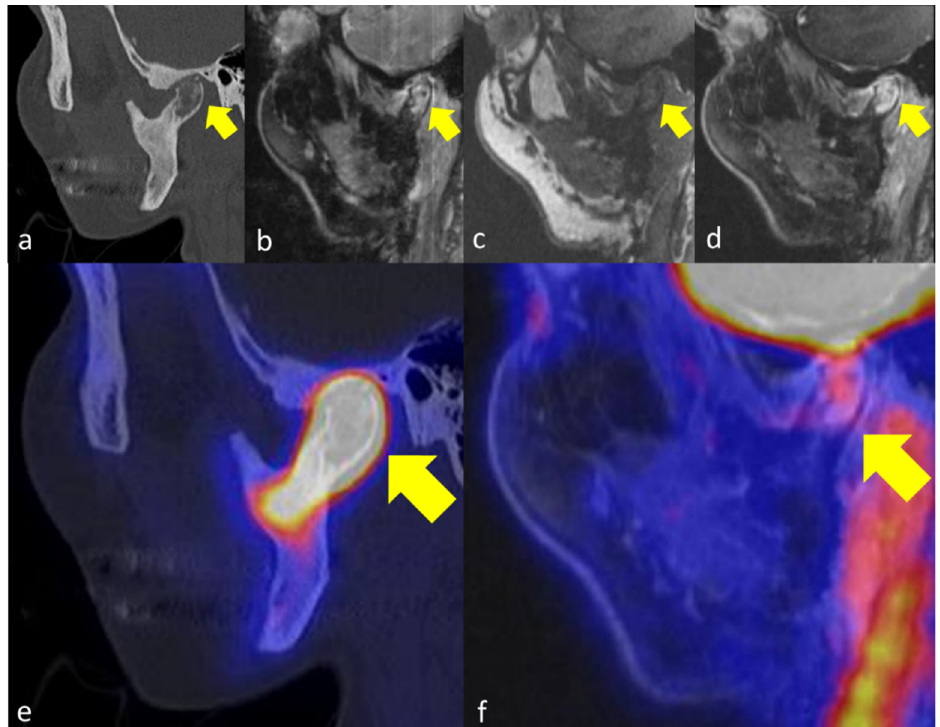
Figure 2. 49 years old female patient with primary chronic OMJ in the right mandibular condyle (yellow arrows). CT ( a ) reveals diffuse trabecular sclerosis and cortical erosion. In the erosive area of the bone, a corresponding edema ( b , c ) can be observed as well as increased gadolinium enhancement ( d ). [18F]fluoride-PET/CT ( e ) and [18F]FDG-PET/MRI ( f ) reveal markedly increased tracer uptake in the OM affected jawbone below the extent of sclerosis.